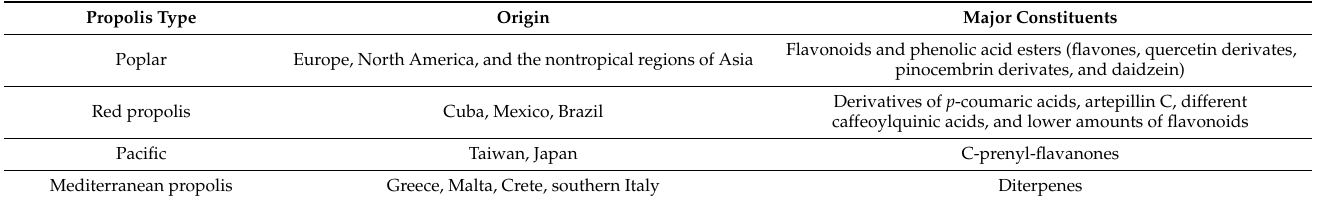
Figure 4. Compositions of propolis. Reprinted from [52]. Table 1. Most important propolis types (resumed from